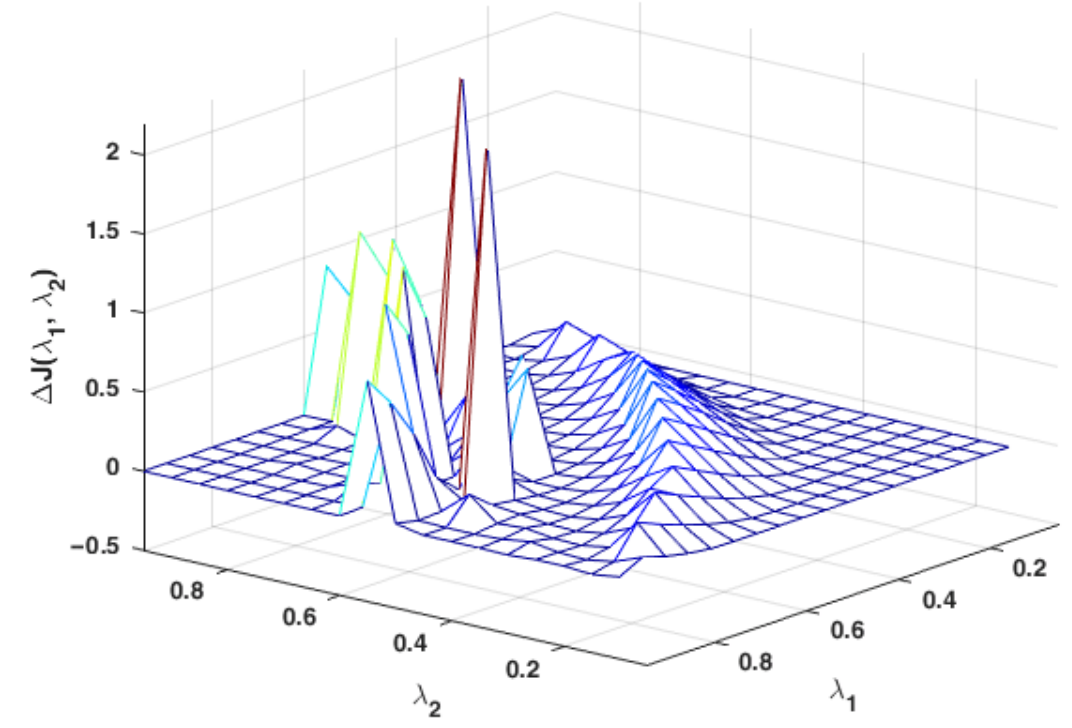
Figure 4. Function Surface (33), which depicts additional error caused by rounding.